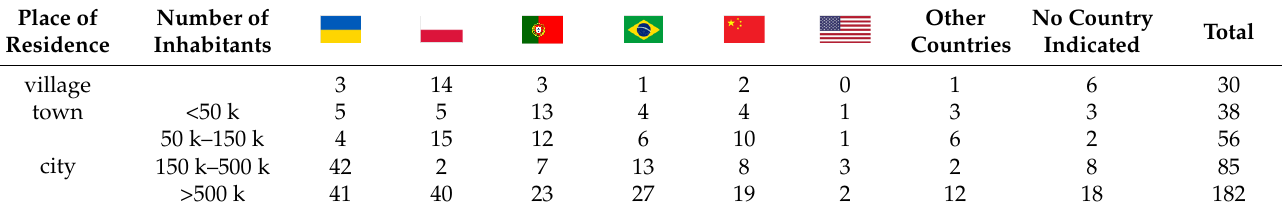
Table 3. The place of residence of questionees.